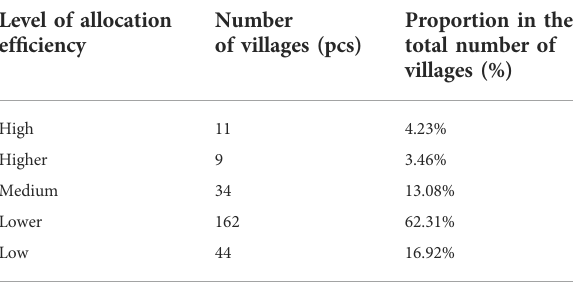
TABLE 4 The allocation ef fi ciency of rural public service land in Pinggu. Level of allocation ef fi